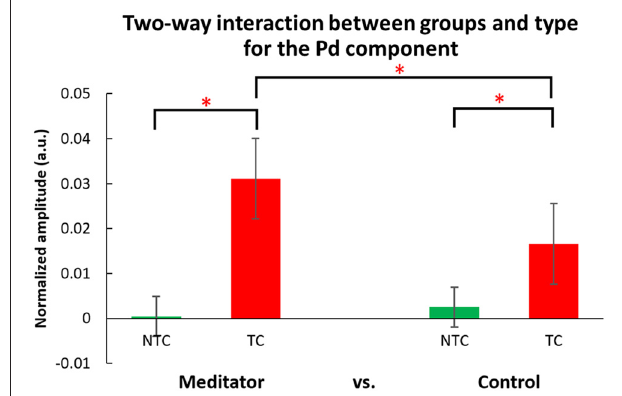
FIGURE 11 | Two-way interaction between group and type for the Pd component. The Pd component (280–380 ms) for the target-colored distractor condition (TC) was significantly larger than for the non-target color distractor (NTC) condition. The meditator group’s Pd in the TC condition was significantly larger than the control group. However, the Pd of NTC did not differ significantly between groups. In this figure, only the two-way interaction of groups and distractor types is shown, and the factor of interventions (pre-test, post-meditation and post-rest) was combined. Error bars indicate 95% confidence intervals. The asterisks ( ∗ ) indicate statistically significance differences ( p <